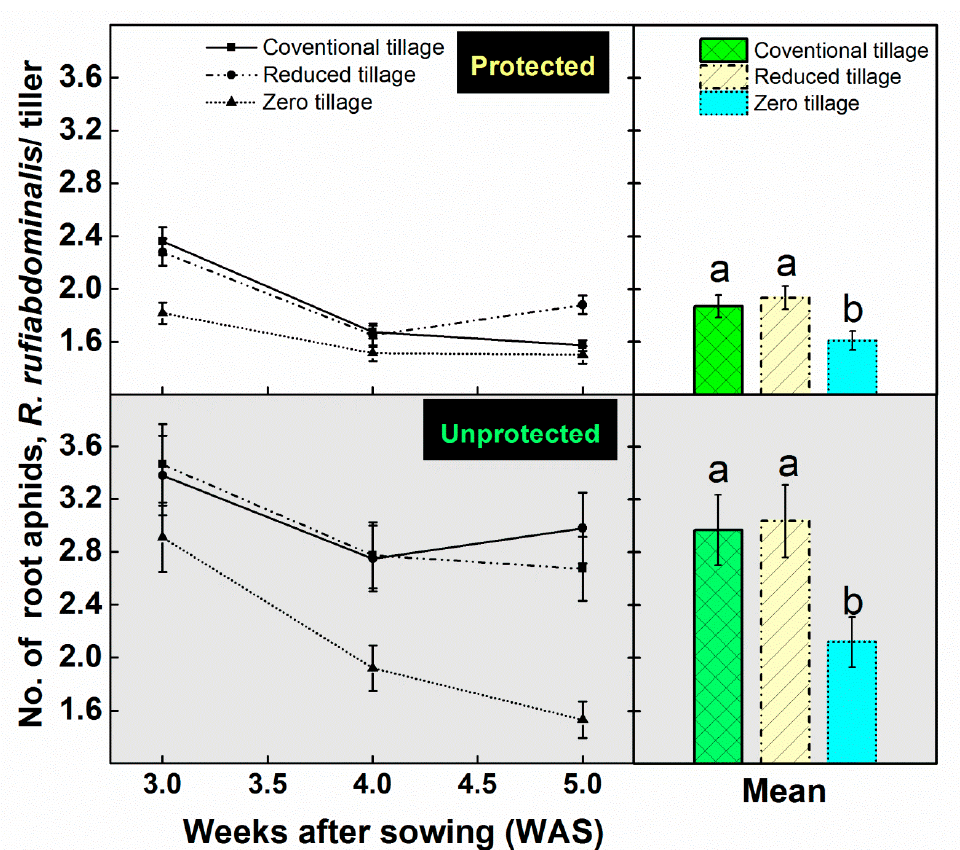
Figure 4. Root aphid, Rhopalosiphum rufiabdominalis (Sasaki) abundance (aphids/tiller) in wheat grown under 3 tillage practices during 2016–2017 and 2017–2018 (pooled). Bars with same letters are not significantly different at p < 0.05. Error bars denote ±1 SE.